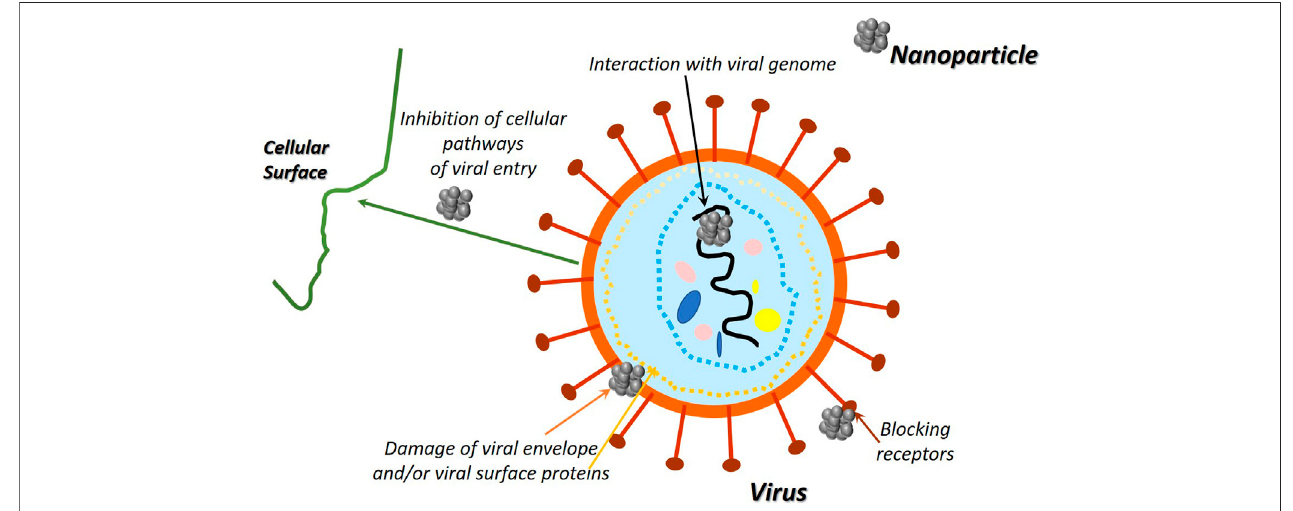
FIGURE 3 | Picture of enveloped and nonenveloped virus structure and of principal chemical biocides showing activity toward enveloped virus deactivation.